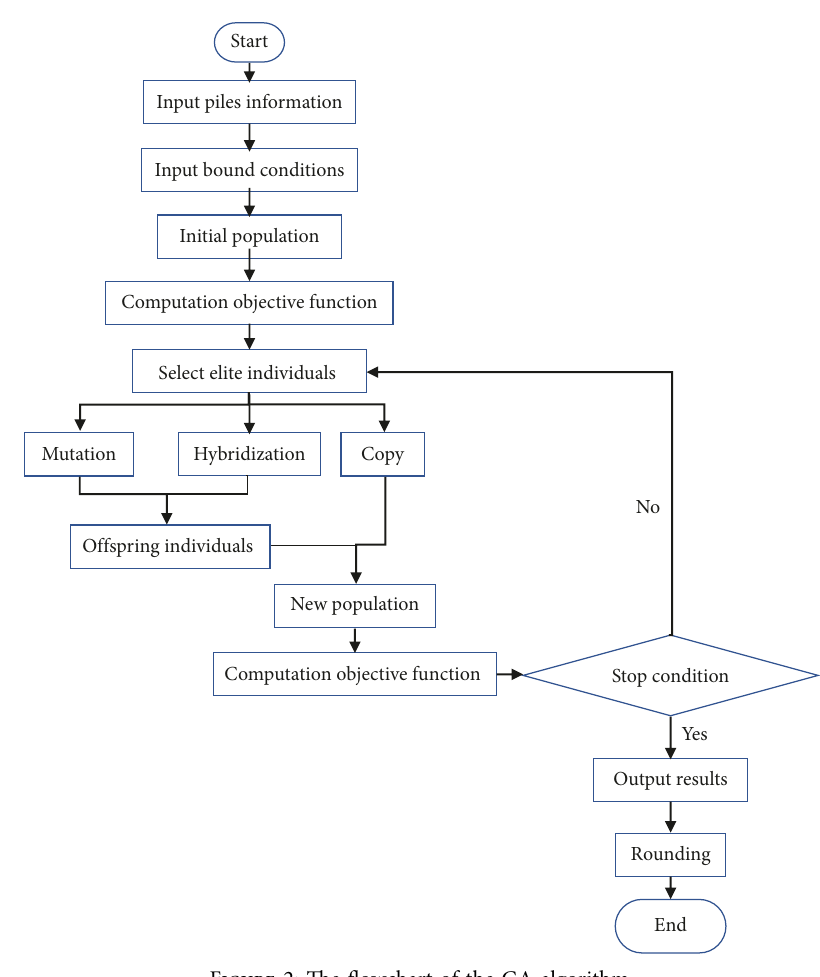
Figure 2: The flowchart of the GA